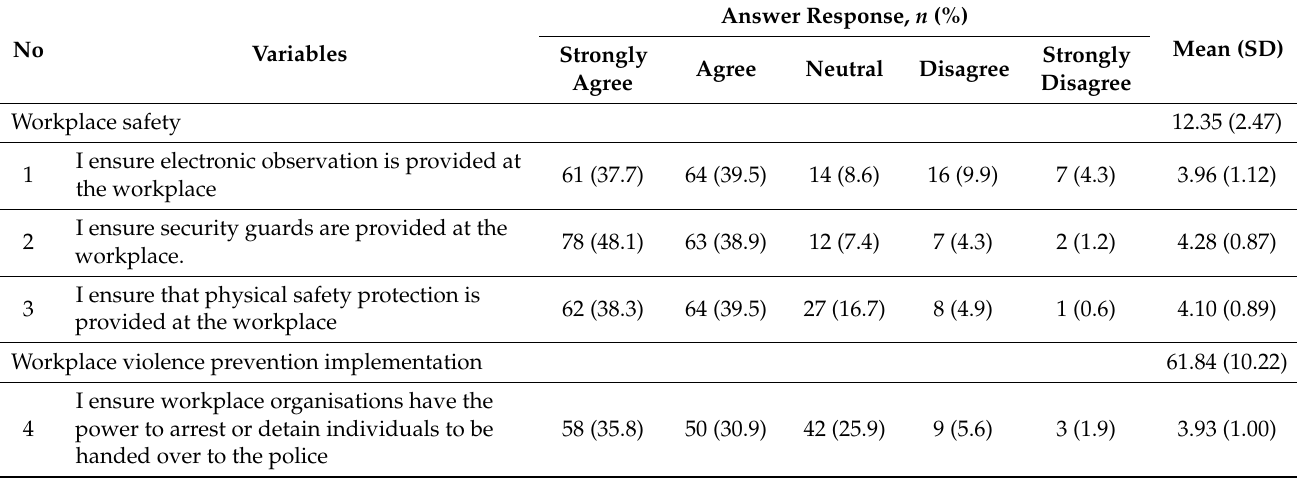
Table 5. Practice towards WPV prevention domain in PPWVP ( n =